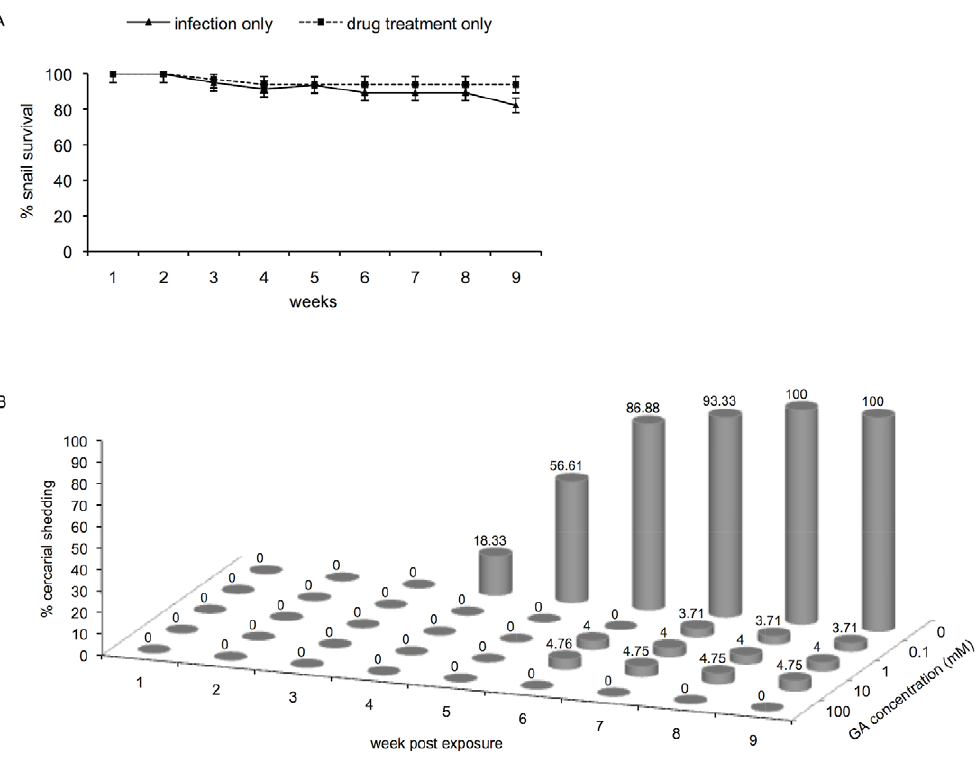
Figure 6. Survival, and cercarial shedding from juvenile susceptible NMRI snails after GA treatment. A ) The percentage of susceptible NMRI snails surviving after either 9 weeks PE to S. mansoni or after treatment with 100 mM GA as described in Materials and Methods. Note that the inhibitor had no toxic effect on the snails. ( B ) Percentage cercarial shedding from GA treated and untreated susceptible (NMRI) snails weeks after infection to S. mansoni . Note that at 5 weeks PE, more than 50% of untreated (0) snails were shedding cercariae while all GA treated snails, even those treated with low doses (0.1–10 mM), remained negative for cercarial release. Data were pooled (12 snails/dose of drug) from 5 independent experiments for the high (100 mM) concentration (N=60) and 3 independent experiments from the low (0.1–10 mM) concentration (N=36) for standard error (SE) determination. At 9 weeks PE all snails treated prior to exposure with the higher dose of inhibitor remained negative for infection.